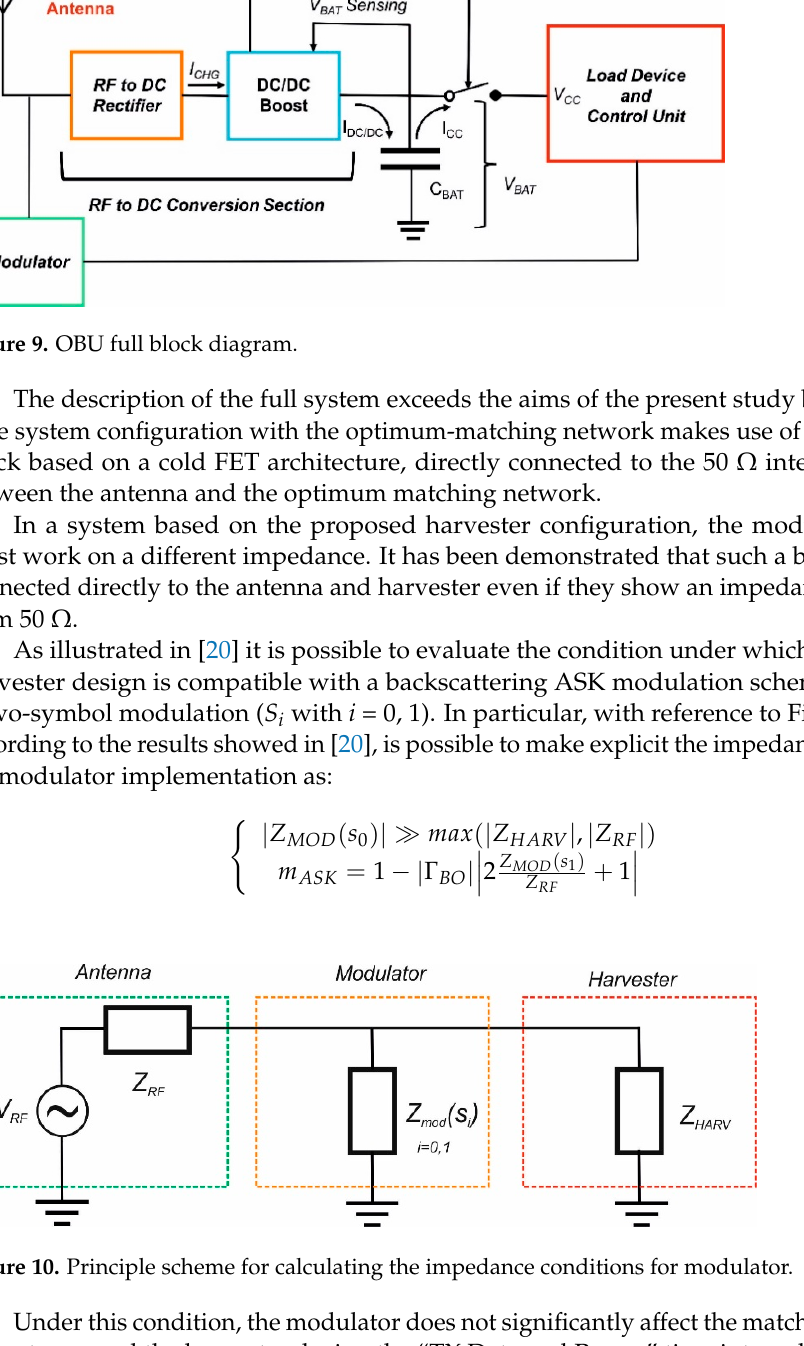
8 of 14 Figure 8. Simulated reflection coefficient evaluated with respect to the optimal impedance (cid:1852) (cid:3042)(cid:3043)(cid:3047) . Figure 7 shows the simulated radiation pattern. The maximum gain of 6.6 dB is achieved in the boresight direction. This good performance proves that the design condi- tions imposed for the optimal impedance do not affect the radiative performance of the antenna. The absence of an external matching network is a strong aid in keeping a high